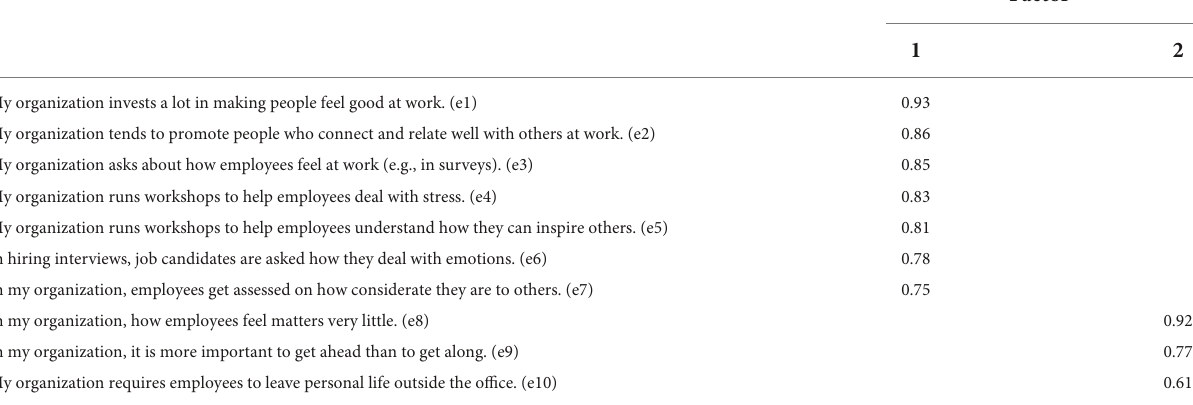
TABLE 1 Study 1–Exploratory factor analysis for EI-related organizational culture items (error number in